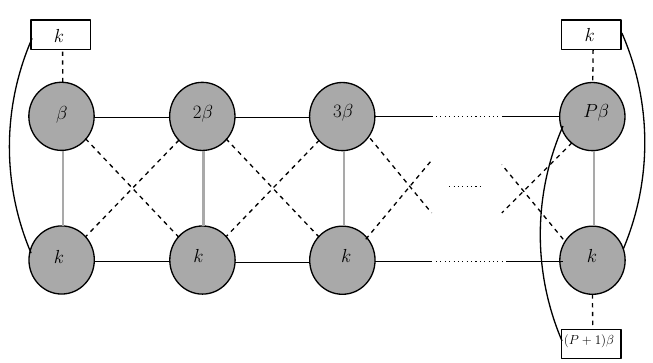
Figure 3 . Example of 2d (0,4) quiver with gauge groups of linearly increasing